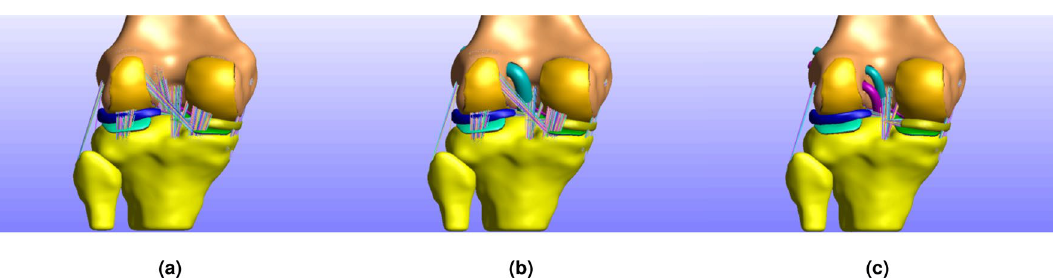
Figure 2. Overview of ACLR surgery modeling workflow. The bone tunnels are “drilled” using cylindrical objects that trace a NURBS curve. ( a ) The NURBS curve is defined based on the anatomical landmarks, ( b ) cylindrical meshes are used for the tunnel “drilling” procedure, ( c ) the “drilled” tibia and femoral tunnels, and ( d ) the graft is morphed to the path and placed precisely through the anatomical landmarks.